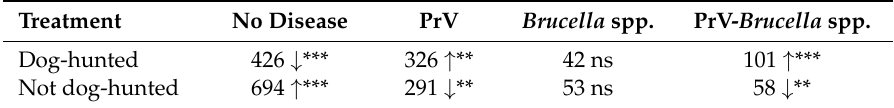
Table 2. Contingency table results for observed frequencies of antibody detection in four categories: No antibodies, pseudorabies virus (PrV) antibodies only, Brucella spp. antibodies only, and the occurrence of both antibodies in populations that were hunted with dogs and populations that were harvested by other means. Direction of arrow indicates whether observed frequencies (provided) were higher ( ↑ ) or lower ( ↓ ) than expected. Significance: ns = not significant; ~ = borderline significant (0.05 < p < 0.10); * p < 0.05; ** p < 0.01; *** p < 0.001. PrV Brucella spp. PrV- Brucella spp.